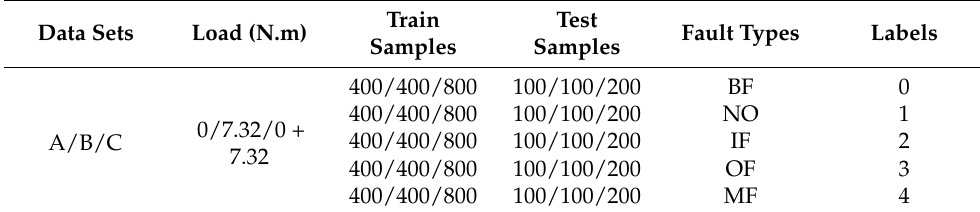
Table 3. Details of data sets.